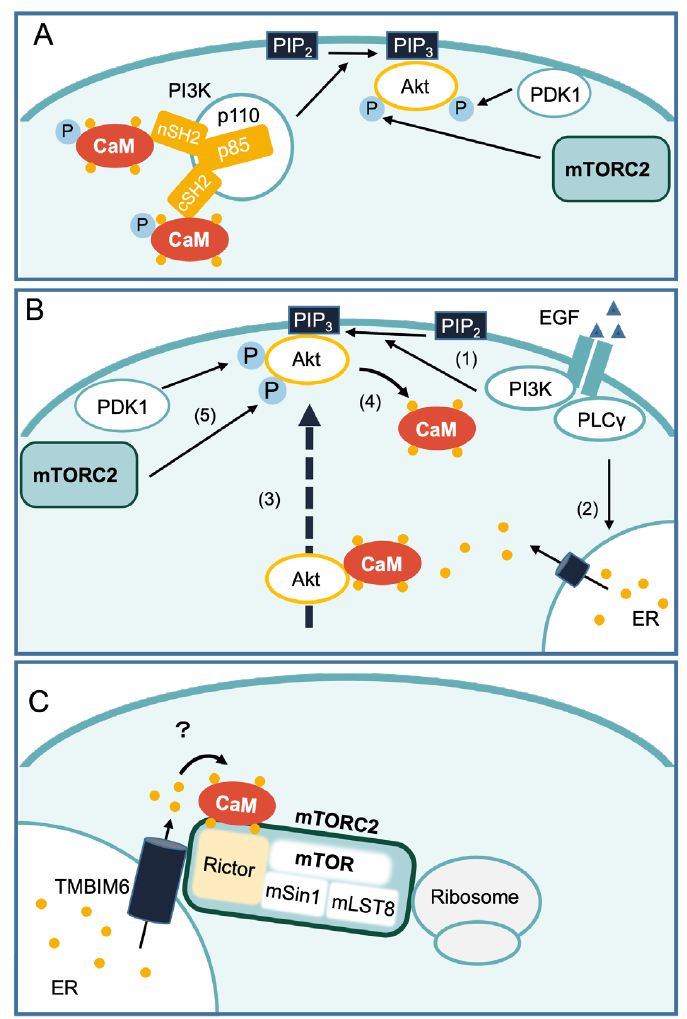
Figure 3. Potential mechanisms of Ca 2+ /CaM-mediated regulation of Akt and mTORC2. ( A ) Ca 2+ /CaM phosphorylated at Tyr99 interacts with the N-terminal domain (nSH2) and the C-terminal domain (cSH2) of the 85kDa regulatory subunits of PI3K (p85) and stimulates kinase activity of PI3K. The generated PIP 3 recruits Akt and PDK1 to the plasma membrane. Akt is fully activated by two kinases, PDK1 and mTORC2. ( B ) EGF induces an intracellular Ca 2+ rise and enhances Akt activity by promoting CaM–Akt binding as follows: (1) EGF binding to EGFR activates PI3K to generate PIP 3 from PIP 2 . (2) EGFR also activates PLCγ and induces Ca 2+ release from the ER via an IP 3 -dependent mechanism. (3) Binding of Ca 2+ /CaM to the PH domain of Akt is proposed to change the conformation of Akt and to facilitate its targeting to the plasma membrane. (4) Binding of Akt to PIP 3 promotes the dissociation from CaM. (5) Akt is phosphorylated by PDK1 and mTORC2 and is fully activated. ( C ) TMBIM6 Ca 2+ channel-like protein interacts with mTORC2. Ca 2+ released from the ER through TMBIM6 is necessary for mTORC2 assembly and association with ribosomes. Be- cause CaM binds to Rictor in a Ca 2+ -dependent manner [33], CaM may mediate Ca 2+ signaling to mTORC2 activation. Ca 2+ is indicated by yellow circles.